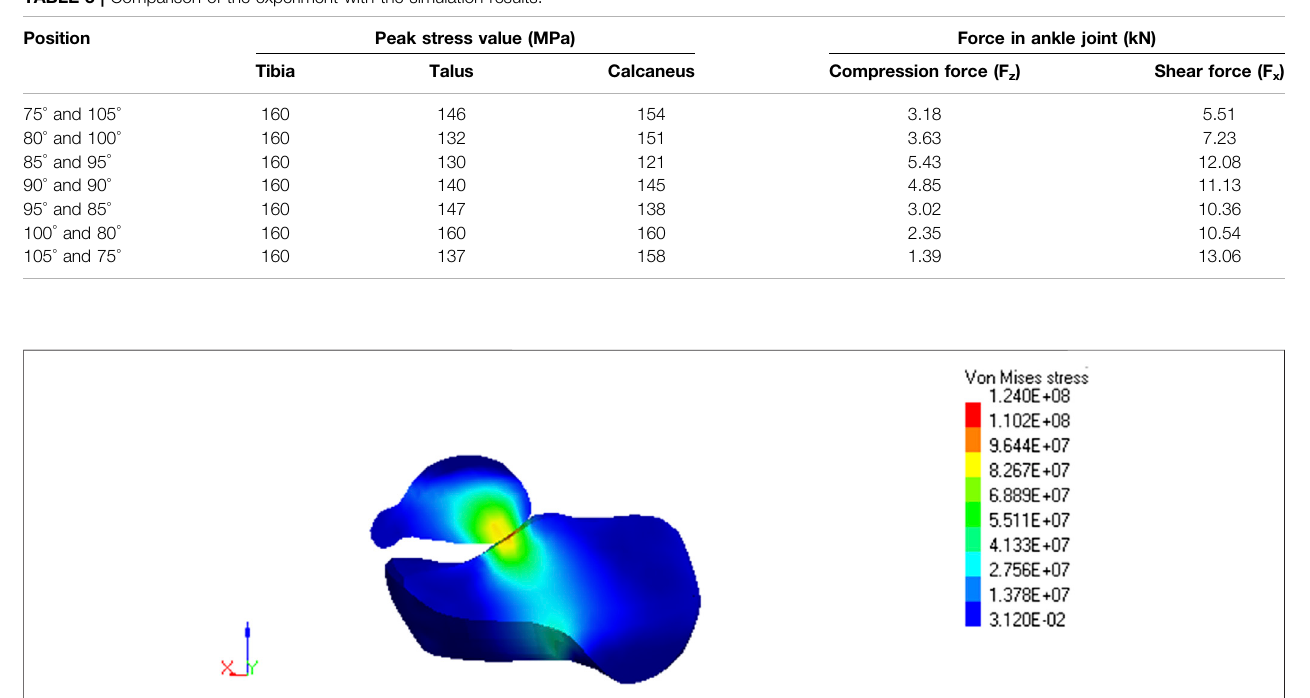
FIGURE 4 | Stress fi eld maps of tallus and calcaneus (ankle joint) at 105 ° and 75 ° position.